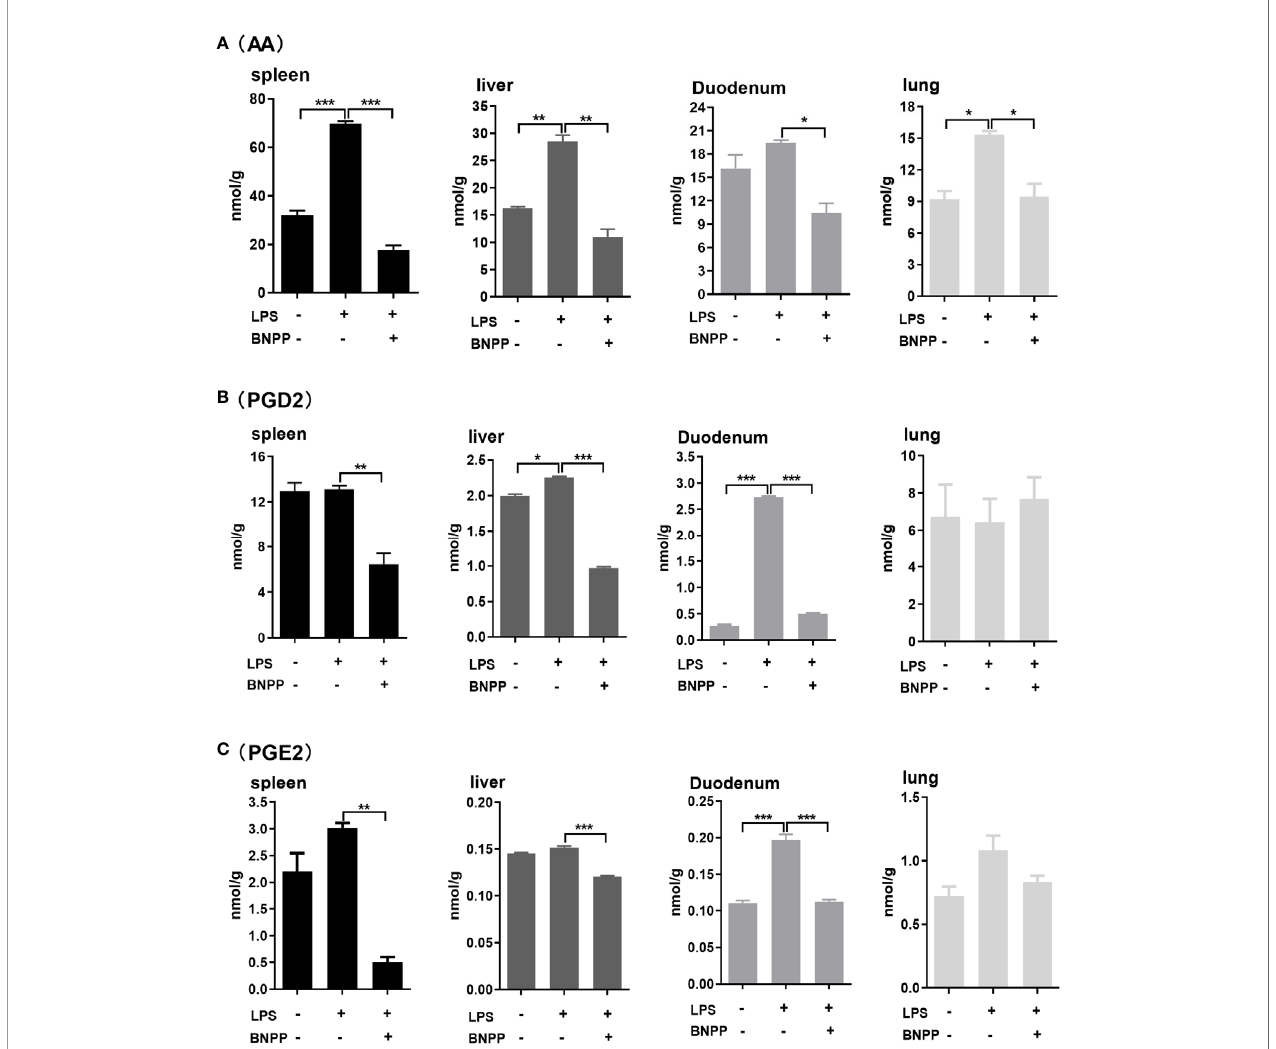
FIGURE 7 | Levels of AA (A) , PGD2 (B) and PGE2 (C) in tissues from pigs treated with BNPP and LPS. Pigs (n = 3) were treated with BNPP (25 mg/kg, i.p.) initially and 1 h later with LPS (25 µg/kg, i.p.) in pigs. Animals were euthanized 24 h after LPS administration. Tissues were harvested, extracted and analyzed for the level of AA, PGD2 and PGE2 with LC-MS/MS. The data in Figure 7 are presented as the mean ± SEM of 3 independent experiments. Statistical signi fi cnce was considered at values of P < 0.05 and indicated by an asterisk (*P < 0.05; **P < 0.01; ***P <